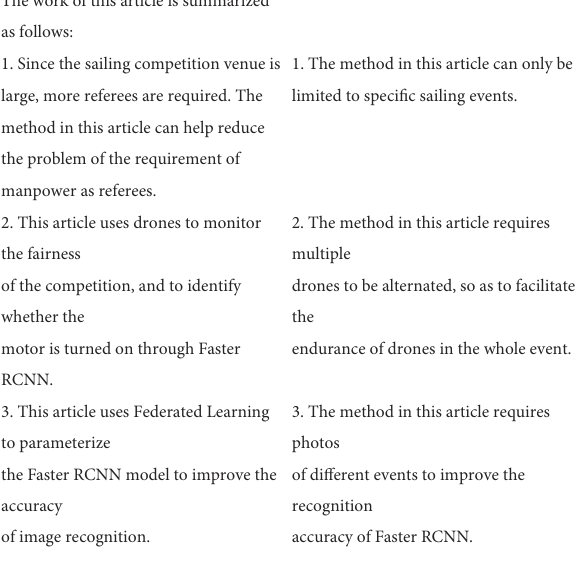
TABLE 1 Summary of existing work and its